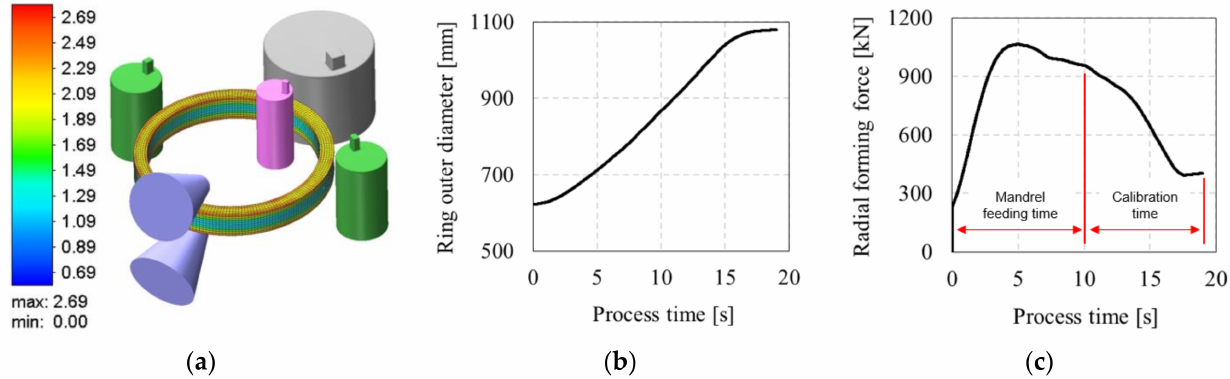
Figure 3. ( a ) Effective plastic strain distribution on the ring at the end of the calibration phase, ( b ) Ring outer diameter and ( c ) radial forming force evolution throughout the simulation process (DF = 1100 mm, 42CrMo4 steel, initial ring temperature of 1200 ◦